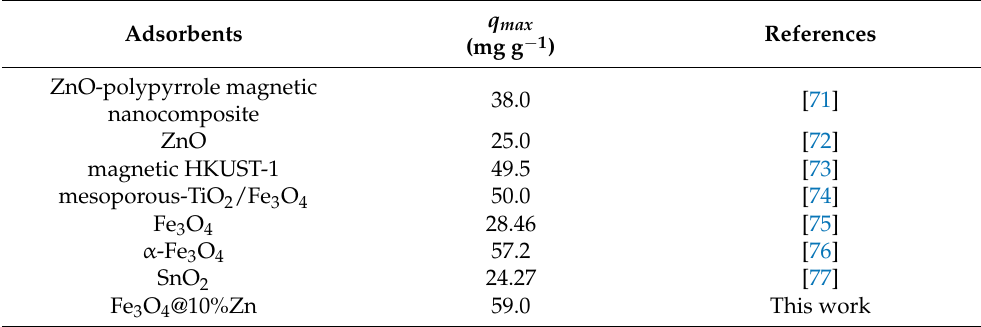
Table 7. Comparison of the maximum adsorption ( q max ) of different adsorbents for the removal of Congo red.